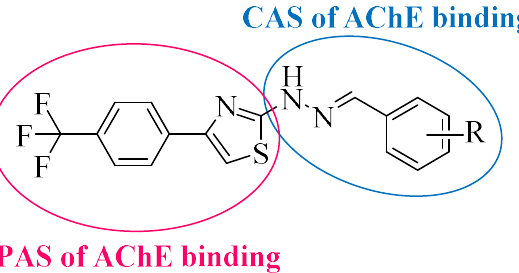
Figure 1. The chemical parts of the target compounds 2a – 2l according to the binding to the catalytic anionic site (CAS) and peripheral anionic binding site (PAS) regions.